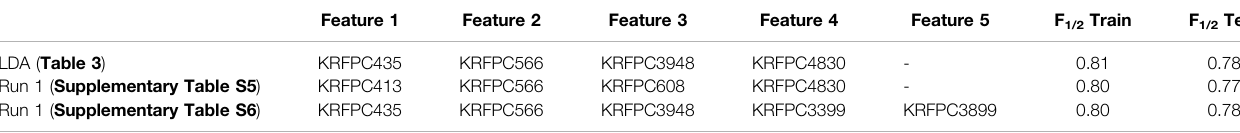
TABLE 4 | Best set of common features found in the complete set of runs.